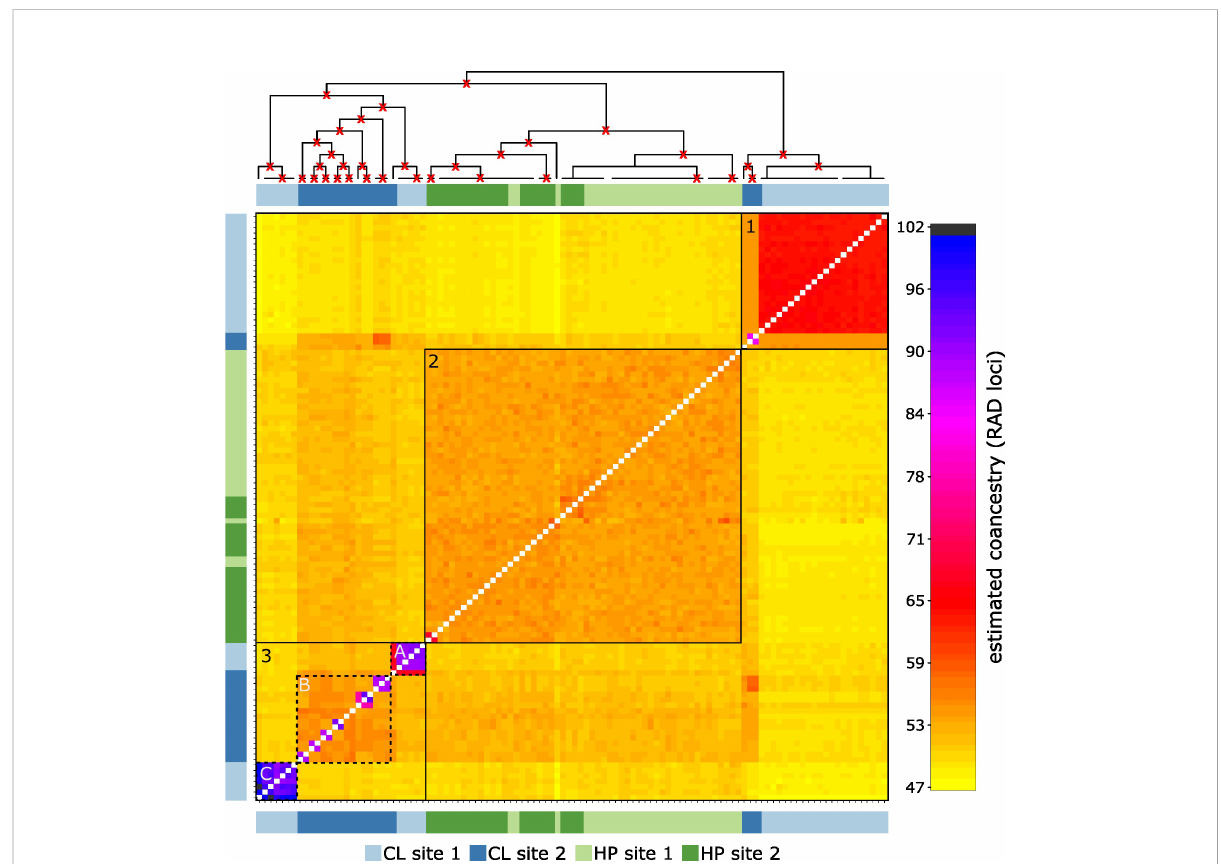
FIGURE 4 Clustered co-ancestry matrix among all individuals of Ecklonia radiata samples at Hamelin Bay, estimated using fi neRADstructure. The heatmap indicates variation in estimated pairwise co-ancestry among all genotyped individuals using the colour scale on the right. The dendrogram on the top indicates the clustering of individuals based on the pairwise matrix of co-ancestry coef fi cients, bootstraps values ≥ 0.90 are indicated with a red cross on the dendogram. Black numbered squares indicate main clusters. Dashed lines indicate subclusters. Legends on the left and below indicate sampling population with CL referring to clonal and HP to haplodiplontic